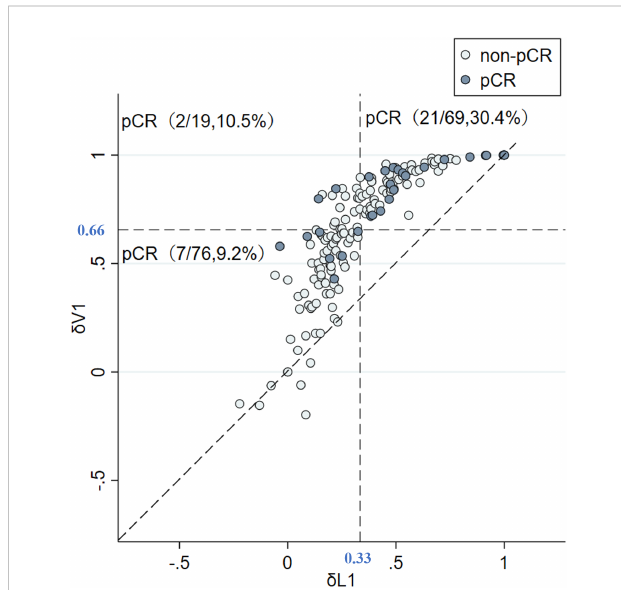
FIGURE 4 d V1 is better than d L1 in evaluating tumor change rate. d V1 did not underestimate the effective cases judged by d L1, and it also identi fi ed underestimated cases by d L1. Abbreviations: pCR, pathological complete response; non-pCR, non-pathological complete response; d V1, volume change rate of EC treatment; d L1, longest diameter change rate of EC